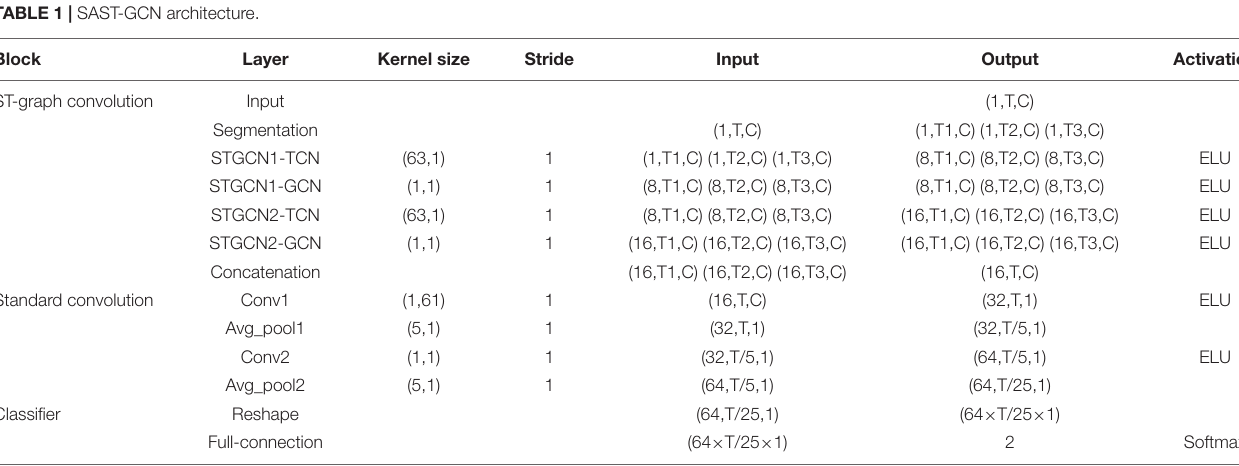
FIGURE 5 | The architecture of the style-based recalibration module. This module is mainly composed of two parts: style pooling and style integration. AvgPool refers to global average pooling; StdPool refers to global standard deviation pooling; CFC refers to the channel fully connected layer; BN refers to batch standardization. TABLE 1 | SAST-GCN